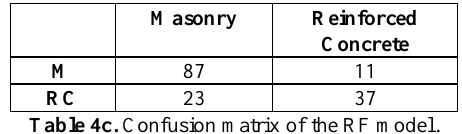
Table 4c. Confusion matrix of the RF model.